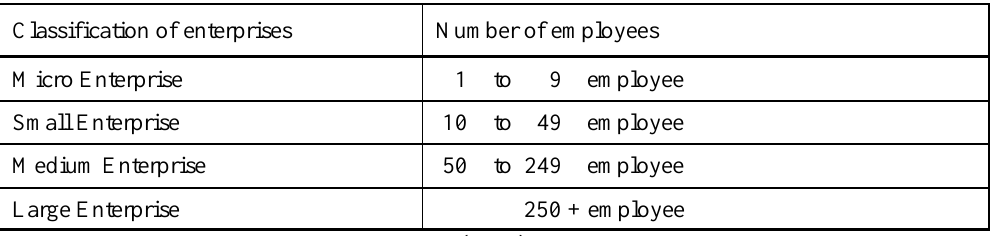
Table 2. Classification of enterprises by size in